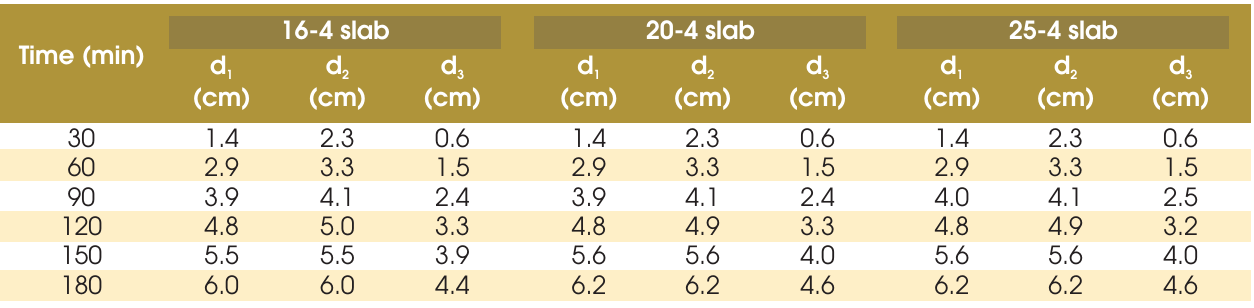
Table 13 – Distances from 500 ºC isotherm for 16-4, 20-4 and 25-4